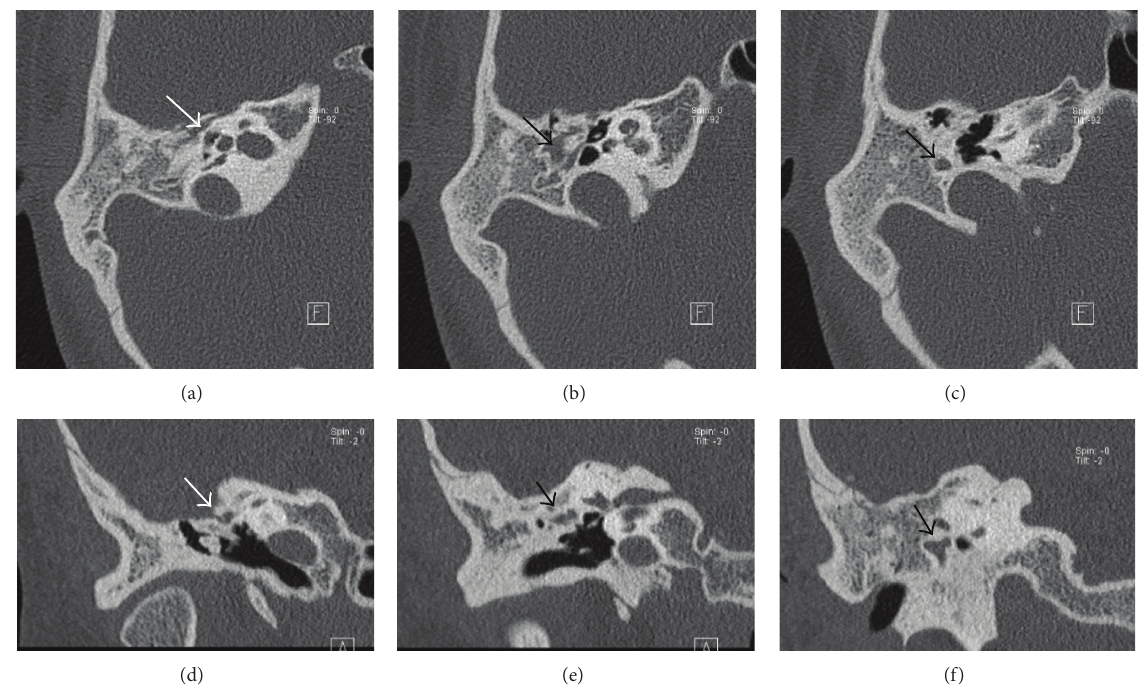
Figure 7: Aural atresia. Axial CT images (a)–(c) demonstrate abnormal facial nerve canal tympanic segment coursing posterolaterally to the middle ear cavity (arrows), instead of the normal posteromedial course. Coronal CT image (d) demonstrates the abnormal proximal tympanic segment of the facial nerve canal coursing superior to the middle ear cavity and ossicles (arrow), instead of its normal medial course. Coronal CT images (e)-(f) showing the abnormal distal tympanic segment and second genu of the facial nerve canal